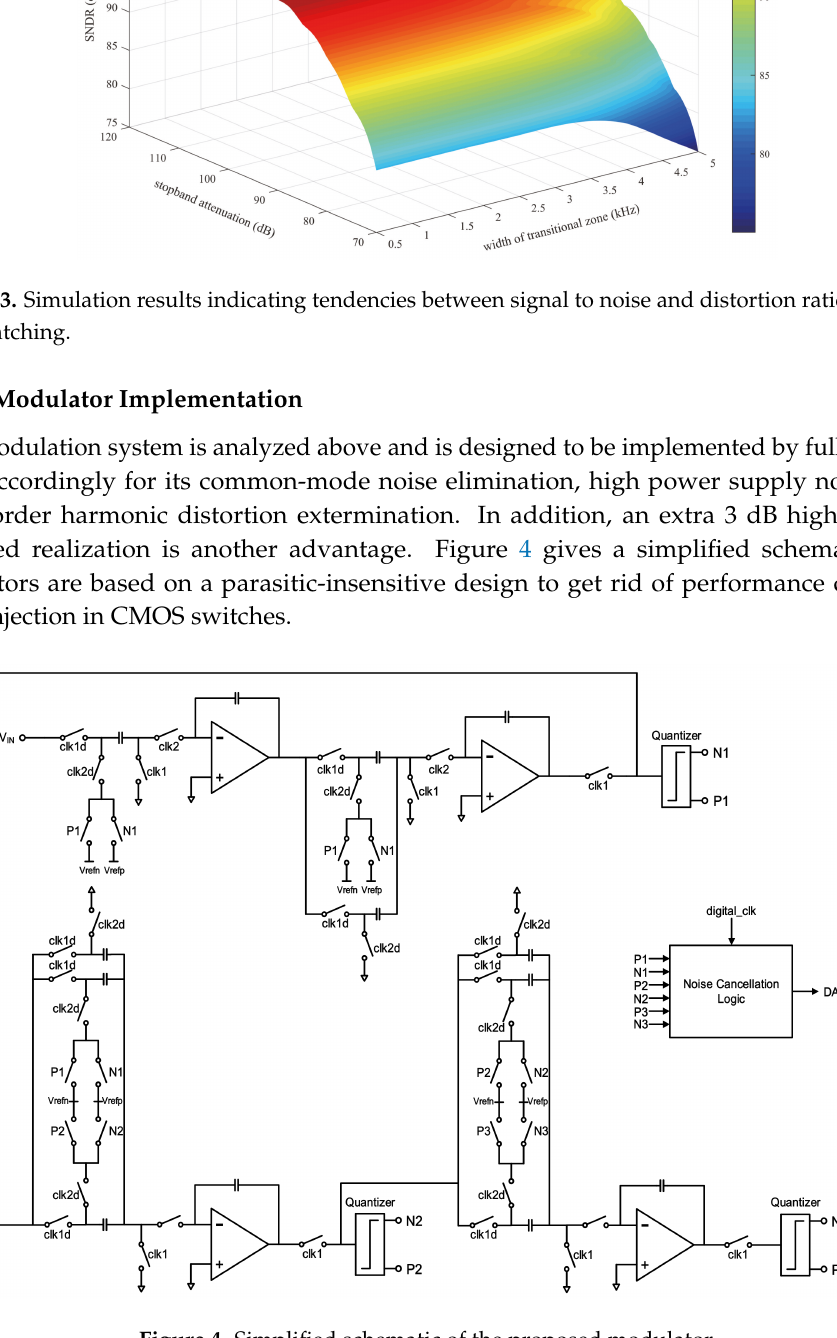
Figure 4. Simplified schematic of the proposed